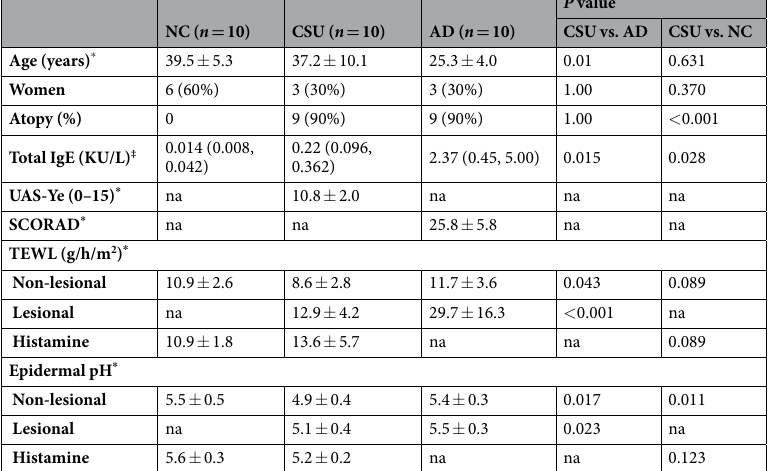
Table 1. Clinical characteristics of the study groups. Histamine, histamine-induced wheals; NC, normal controls; AD, atopic dermatitis; CSU, chronic spontaneous urticaria; UAS, urticaria activity score; SCORAD, scoring atopic dermatitis; TEWL, transepidermal water loss; na, not available. * Values given are the mean ± S.D. ‡ Values given are the median (25 th percentile, 75 th percentile). P values were obtained by the Mann-Whitney u test (continuous variables) and Fisher’s exact test (categorical